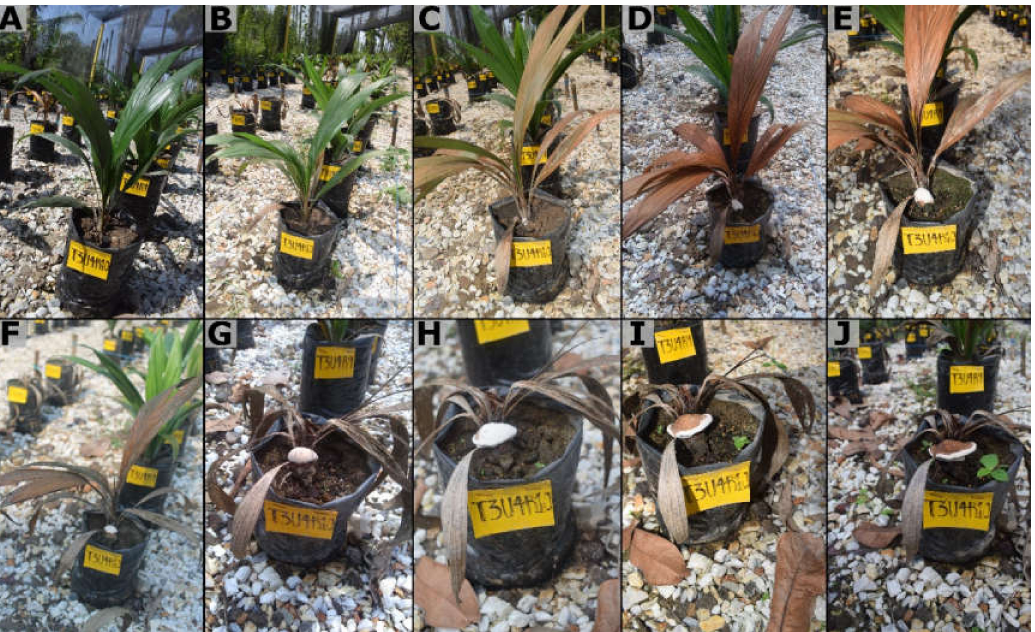
Figure 3. Progression of the symptom of basal stem rot in four-month-old oil palm seedlings inocu- lated with Ganoderma zonatum. ( A ) Asymptomatic infected seedlings at 15 weeks post inoculation (wpi). ( B ) Seedling infected at 18 (wpi) with necrosis on lower leaves. ( C ) Seedling at 21 wpi with generalized necrosis and mycelium formation at the base of the stem. ( D – F ) Infected seedling >23 wpi with visible basidiocarp. ( G – J ) seedling infected at >26 wpi shows complete basidiocarp formation.